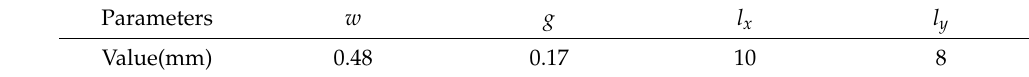
Table 1. Final parameter vales of a rectangular PSC.